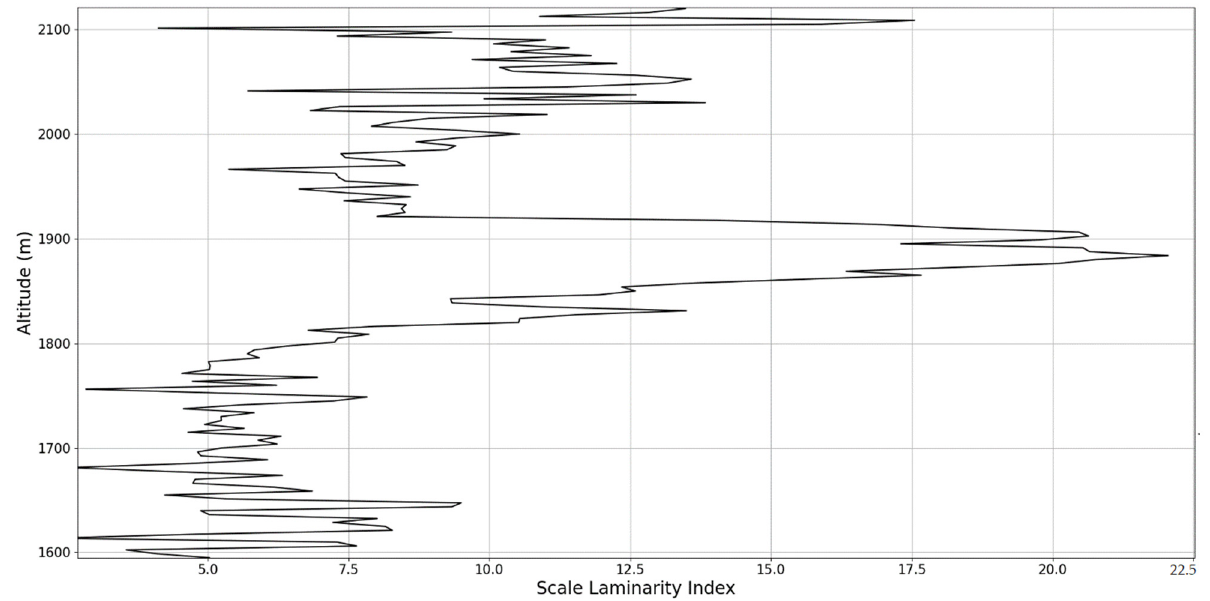
Figure 27. Zoomed-in scale laminarity index profile plot corresponding to point A.